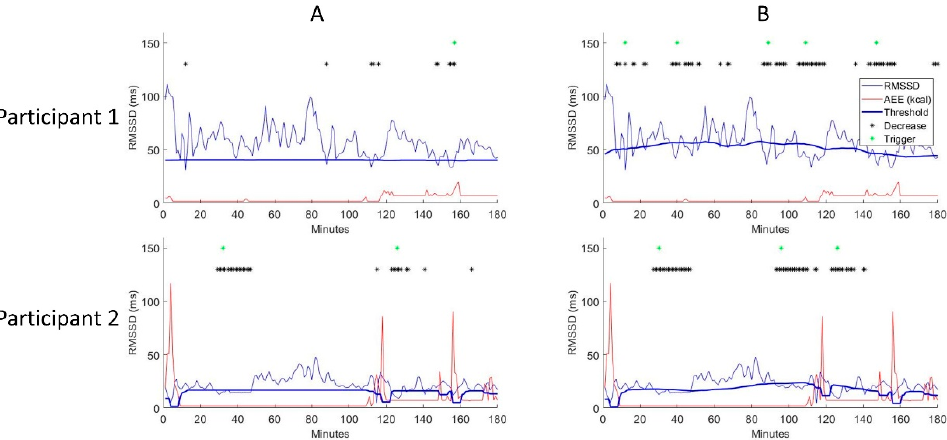
Figure 3. Example of a simulation for two firefighters. Both algorithms were run with a window threshold of 4 and a window length of 6 (i.e., 4 out of 6) with a silent period of 20 min in between. The figure illustrates an observation time of 3 h. The x -axis depicts minutes and the y -axis RMSSD. The red line represents the amount of AEE (kcal), the blue line is the actual RMSSD, and the bold blue line represents the estimated threshold (predicted RMSSD—0.5 × SD RMSSD calibration ). Green asterisks indicate AddHRVr triggers, and the black asterisks indicate a 1-min segment with the actual HRV being lower than the predicted threshold. Panel ( A ) represents a static and Panel ( B ) a dynamic AddHRVr algorithm.